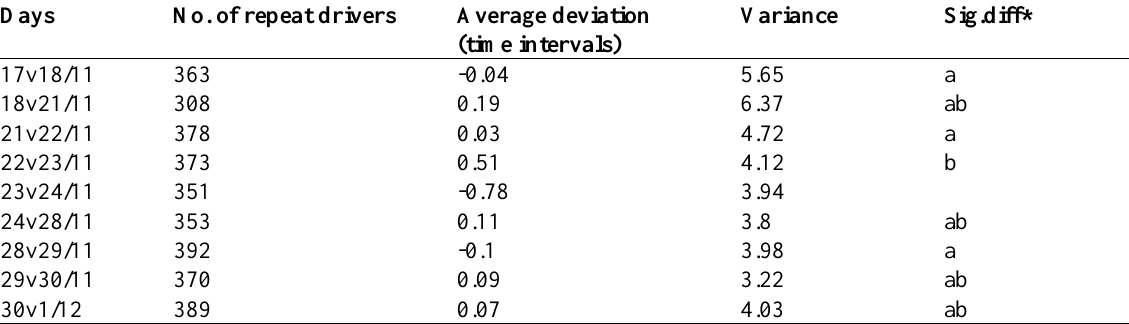
Table 5. An ANOVA on the effect of day on the average deviations in arrival time (number of 5-minute time slot differences) for repeat journeys during the 1994 Cobden Bridge